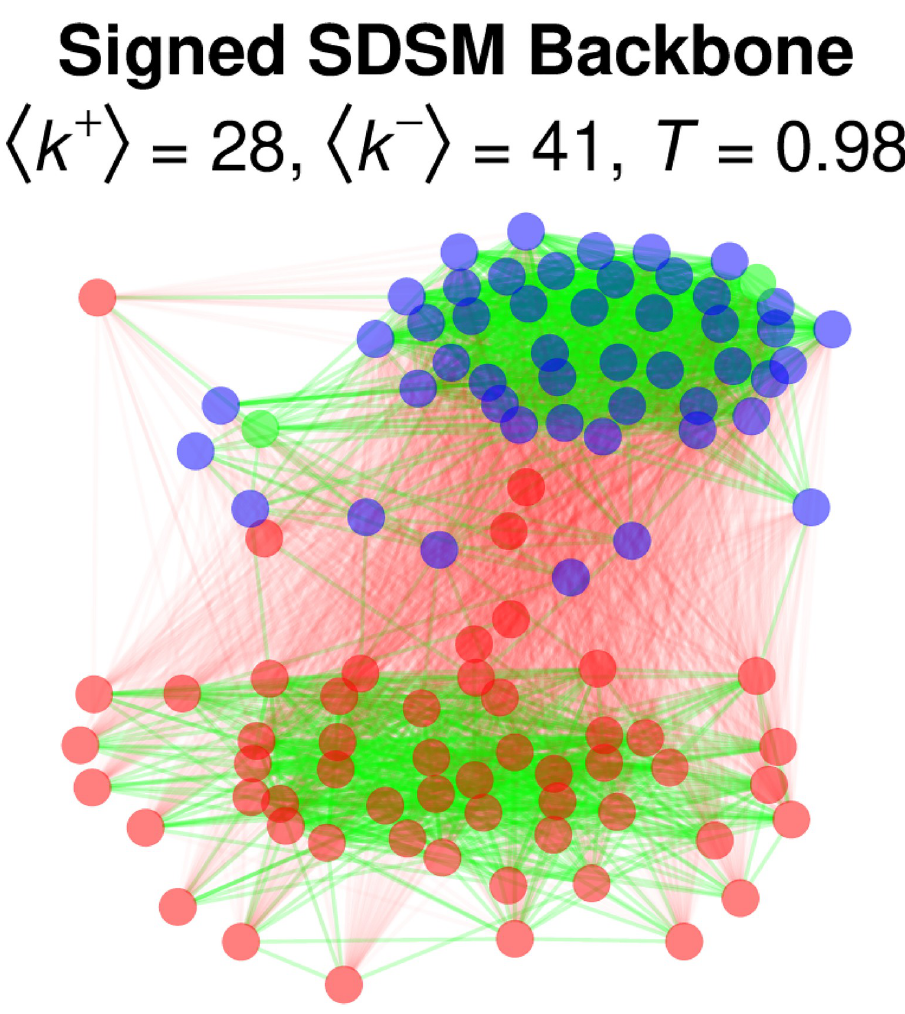
Fig 11. Extracting the signed backbone of a bipartite projection of bill co-sponsorship in the 115 th US Senate.